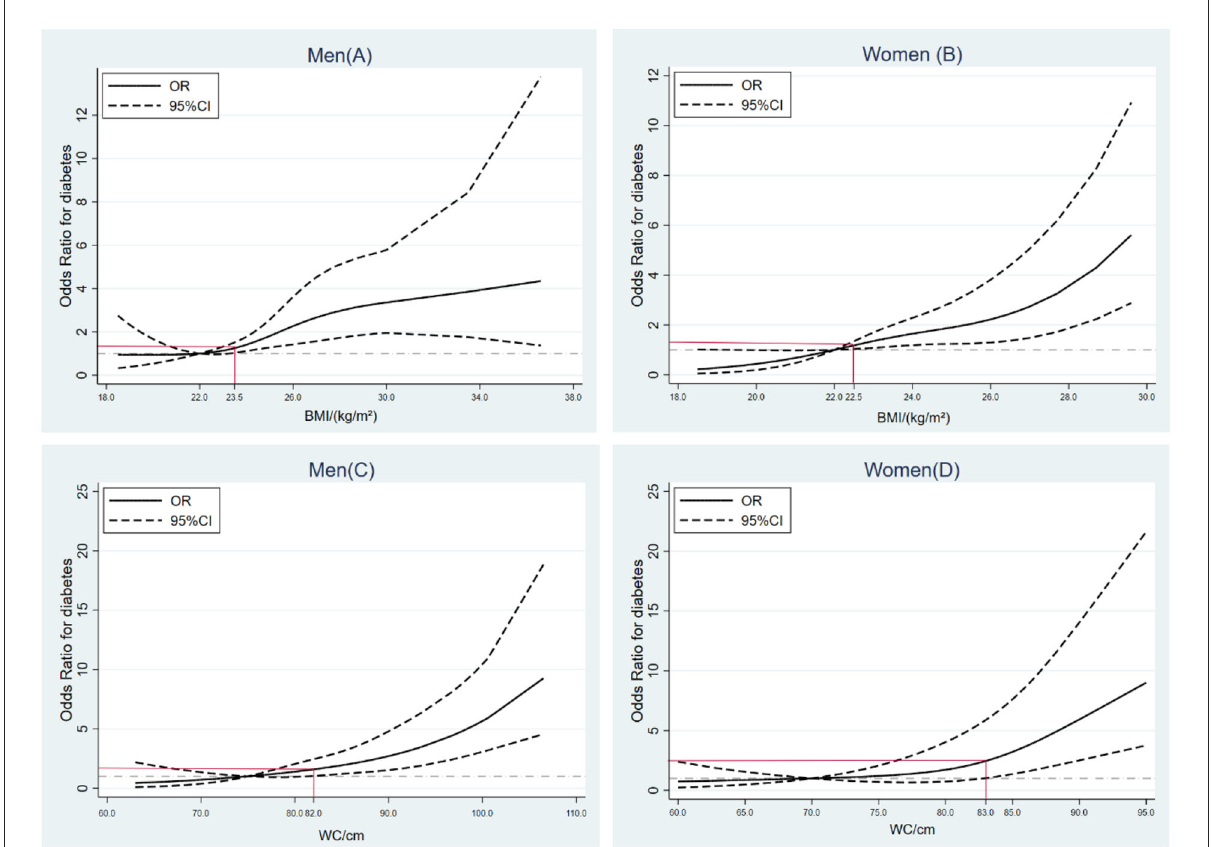
FIGURE1 Exposure–response relationships between BMI/waist circumference (WC) and risk of type 2 diabetes by restricted cubic spline for adjusted modified logistic regression model with the estimation of odds